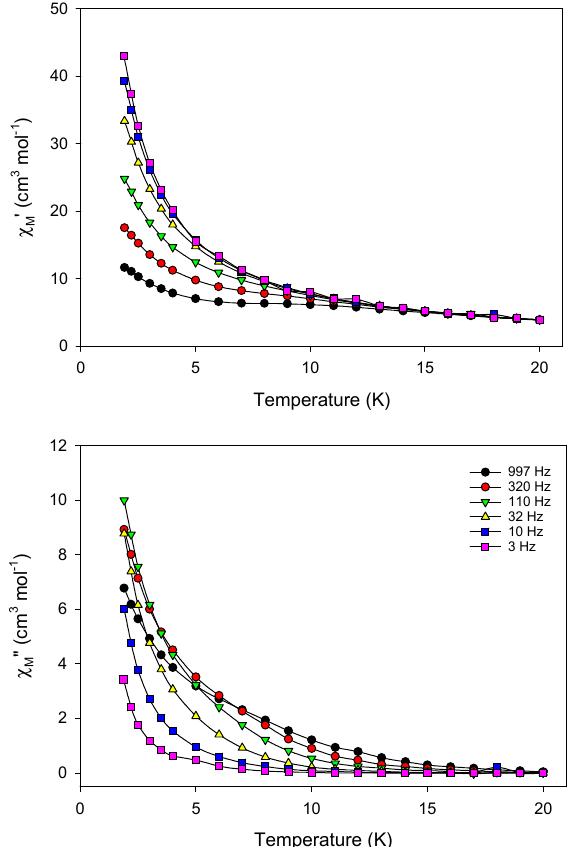
Figure 5. Temperature dependence of the in-phase ( χ Μ ′ , top ) and out-of-phase ( χ Μ ′′ , bottom ) ac magnetic susceptibilities at zero dc field for 1 ∙ 3MeOH ∙ CH 2 Cl 2 , measured in a 3.0 G ac field oscillating at the indicated frequencies. The solid lines are guides only.